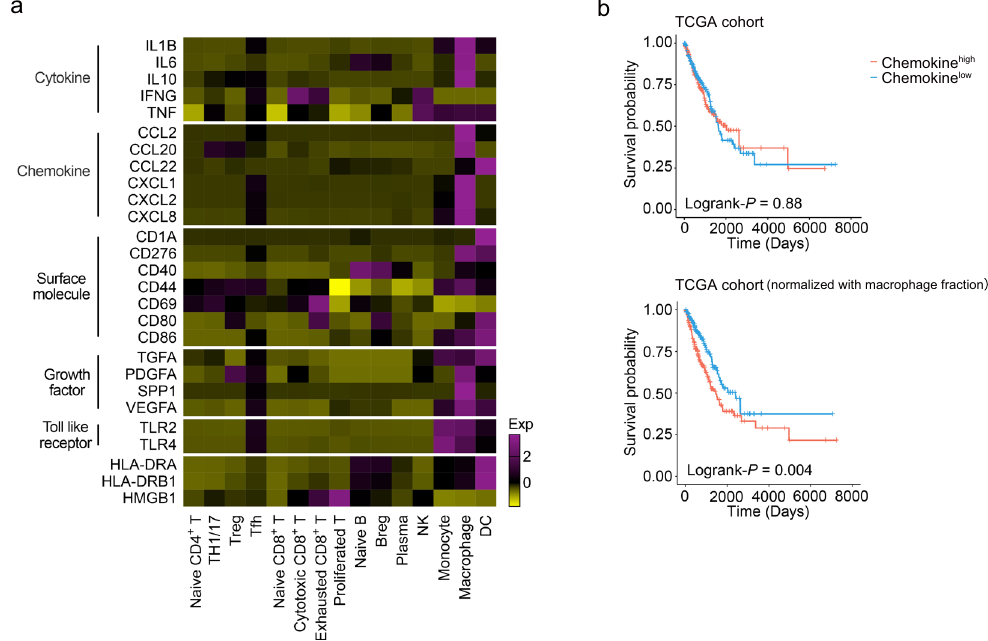
Fig. 7 Expression and survival analysis of genes associated with MPE formation. a The heatmap shows the mean expression of genes previously indicated to be associated with MPE formation. b The Kaplan – Meier overall survival curves of TCGA LUAD patients grouped by the gene signature of chemokine. The high and low groups are divided by the median value of mean expression of chemokine (upper panel) or with normalization by CIBERSORT (lower panel). Statistical signi fi cance was calculated using two-sided log-rank